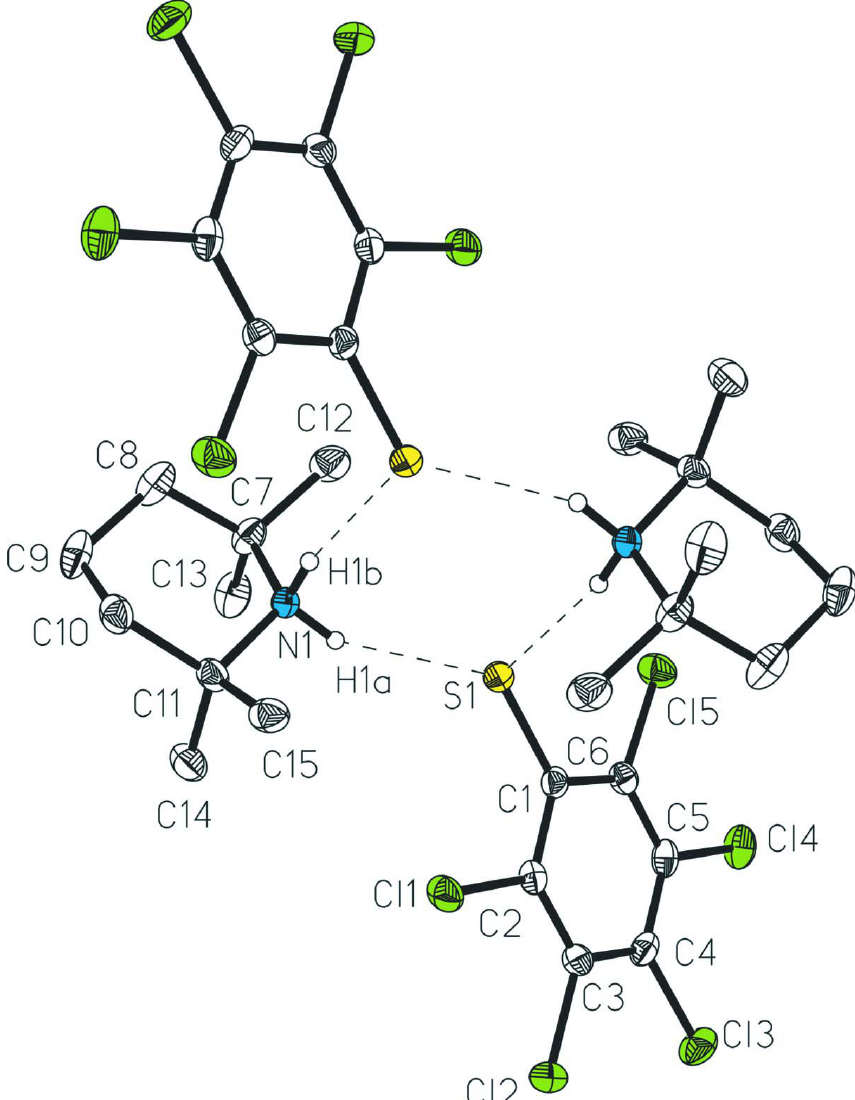
Figure 1 Structure of [C 50% probability level. C-bound H atoms have been omitted for